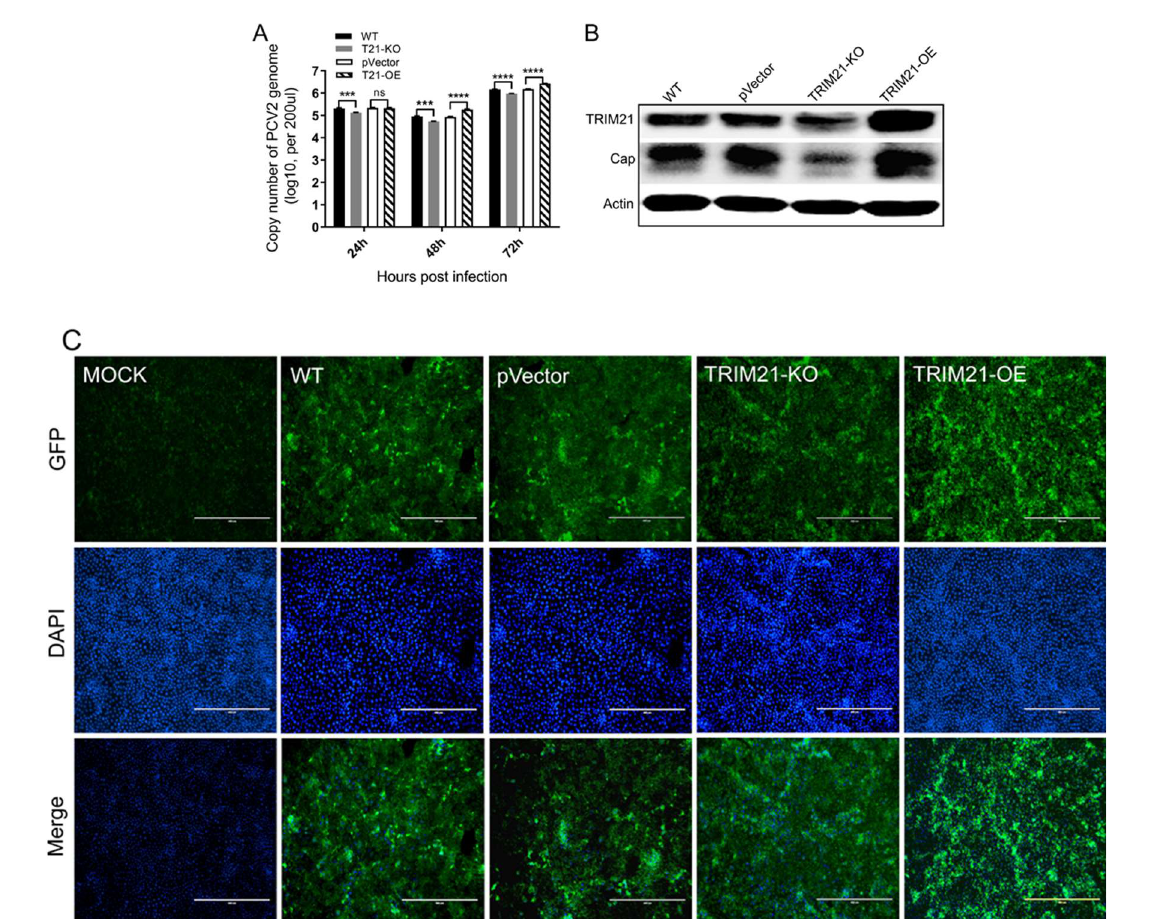
Figure 3. Porcine TRIM21 enhances PCV2 infection. ( A ) qRT-PCR. Cells were infected with PCV2 for 24, 48, or 72 hpi, and the copies of the PCV2 genome were evaluated by qRT-PCR. *** p < 0.001;